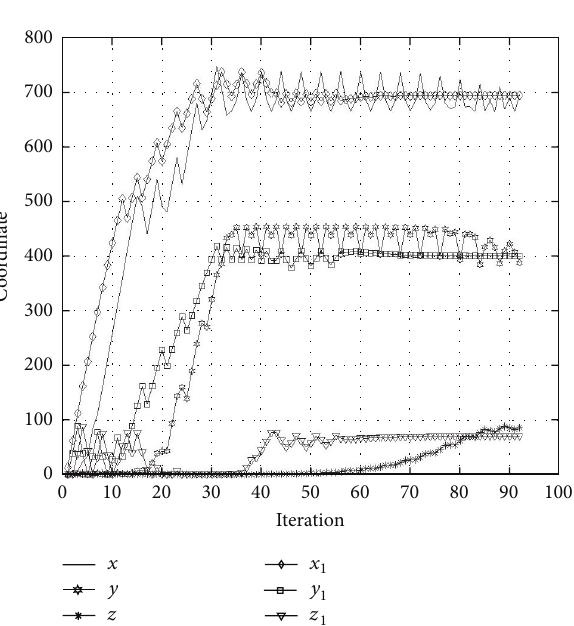
Figure 9: Location convergence